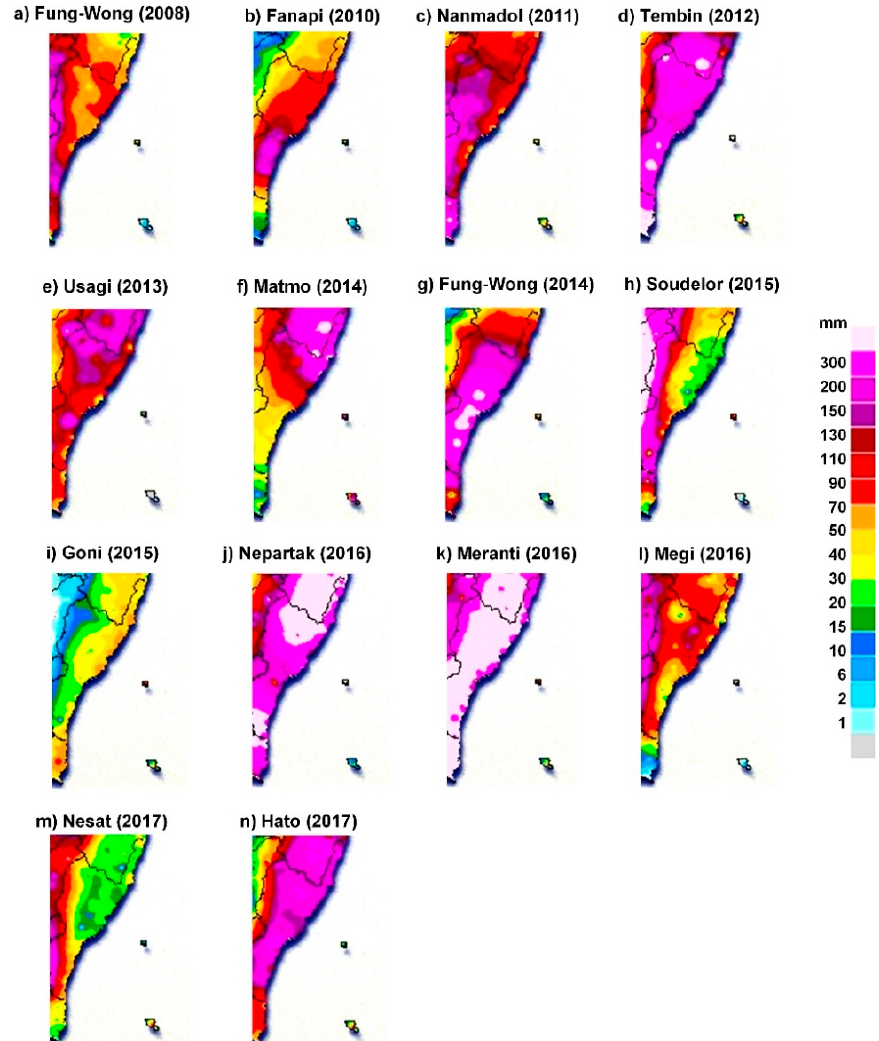
Figure 2. Spatial distribution of 24-h accumulated rainfall over the study area: ( a ) Fung-Wong (2008); ( b ) Fanapi (2010); ( c ) Nanmadol (2011); ( d ) Tembin (2012); ( e ) Usagi (2013); ( f ) Matmo (2014); ( g ) Fung-Wong (2014); ( h ) Soudelor (2015); ( i ) Goni (2015); ( j ) Nepartak (2016); ( k ) Meranti (2016); ( l ) Megi (2016); ( m ) Nesat (2017); ( n ) Hato (2017). Regarding meteorological data, this study collected ground-weather characteristics at four stations. Each station has 12 characteristics, including ground air pressure (hPa), air pressure at sea level (hPa), ground temperature ( ◦ C), ground dew-point temperature ( ◦ C), ground relative humidity (%), ground global solar radiation (MJ/m 2 ), ground vapor pressure (hPa), surface wind speed (m/s), surface wind direction (deg), maximum instan- taneous wind speed (m/s), instantaneous wind direction (deg), and precipitation (mm/h). A single station can collect 2544 pieces of hourly records. This study used a correlation coefficient greater than 0.3 (i.e., at least a moderate correlation) between characteristics and precipitation as the characteristic screening threshold, and all four stations were screened simultaneously. In addition to the target precipitation characteristics, four other